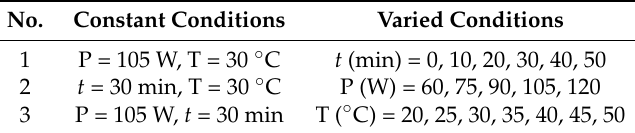
Table 1. Ultrasonic dispersion experiments of nano-Al 2 O 3 ASW suspensions.